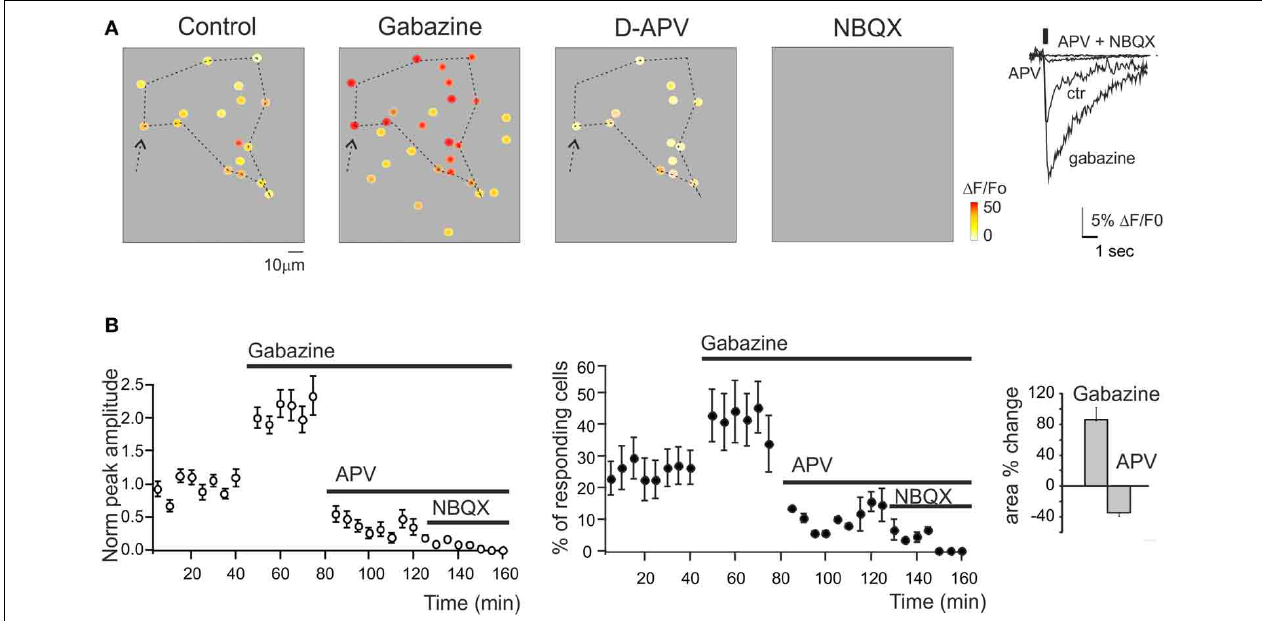
FIGURE 3 | Regulation of GrC activity by synaptic receptor blockers. (A) Activity maps of the granular layer showing the peak intensity of neuronal responses on a color scale. The location of colored dots corresponds to that of neurons in the slice. The four panels (from left to right) show that both the activation intensity and the number of active GrCs increase remarkably during 10 μ M gabazine application, decrease following addition of 50 μ MAPV, and are fully blocked following further addition of 20 μ M NBQX. Note the variation of the responding area (dashed